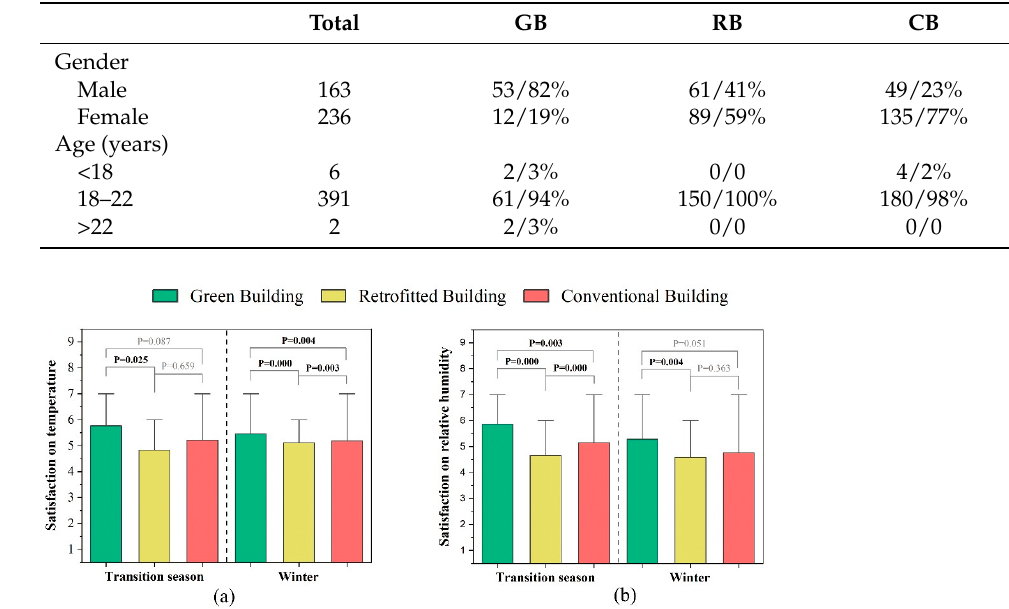
Table 7. Background information on respondents.